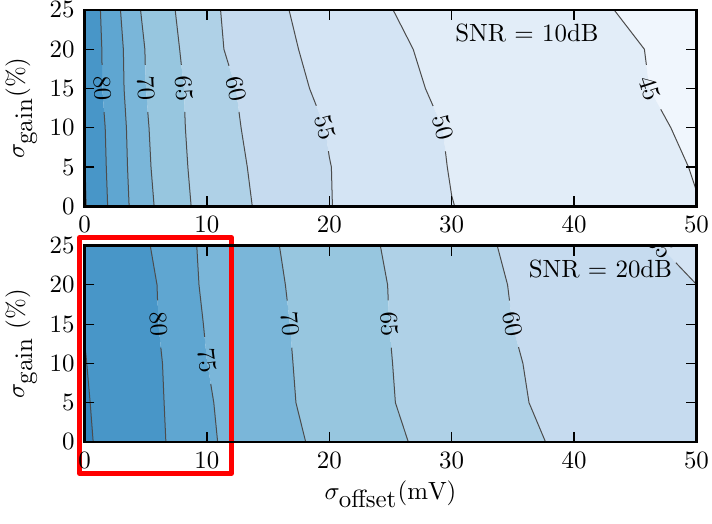
Figure 11. Average classification rate variation over gain/offset standard deviation and added noise values for the vehicle classification